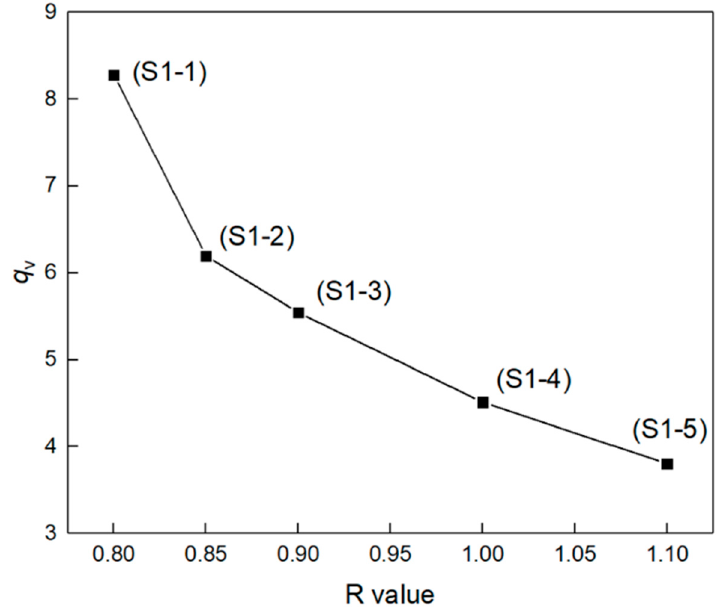
Figure 3. Equilibrium volume-swelling ratios of elastomers with different R values.